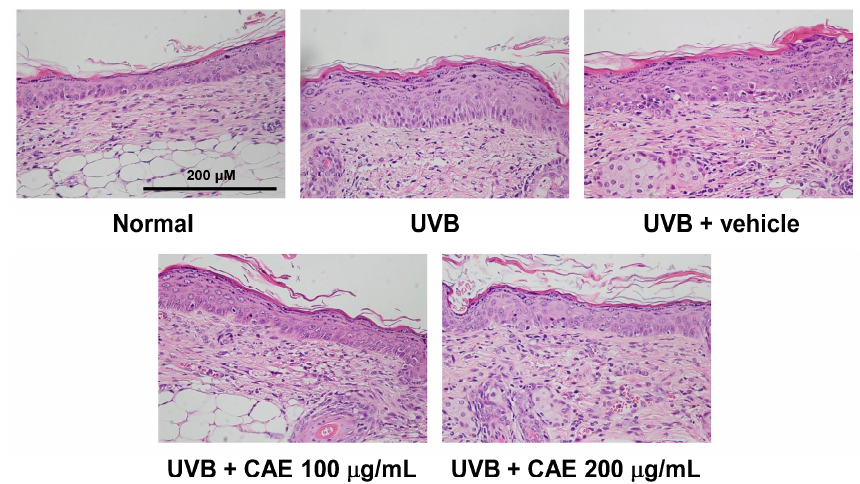
Figure 14. Light micrographs of the histological sections of hairless mice stained with H & E.